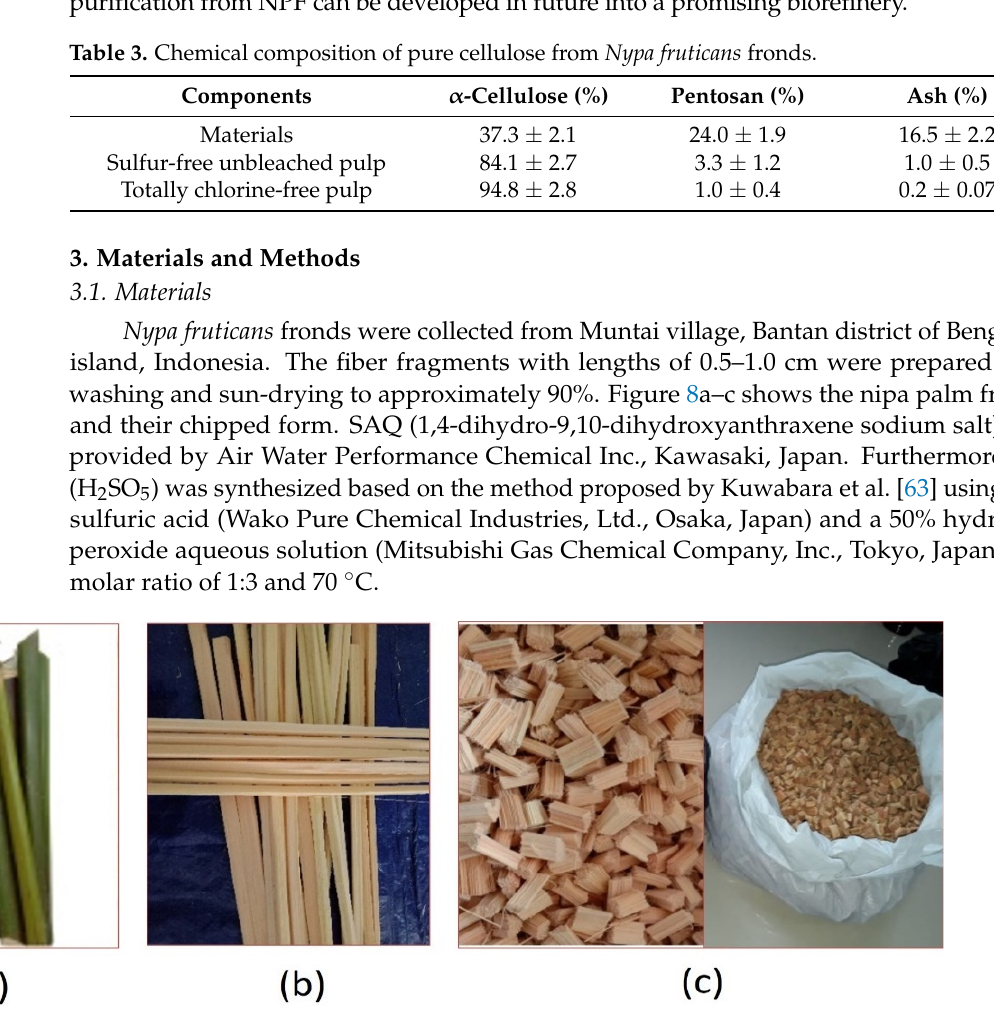
Figure 8. Nipa palm fronds received ( a ); peeled ( b ), and; chipped ( c